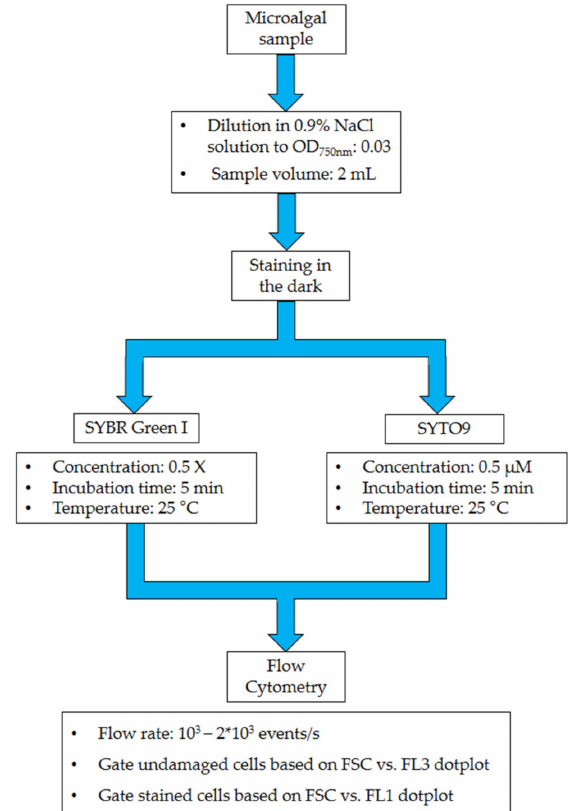
Figure 4. Schematic representation of the validated